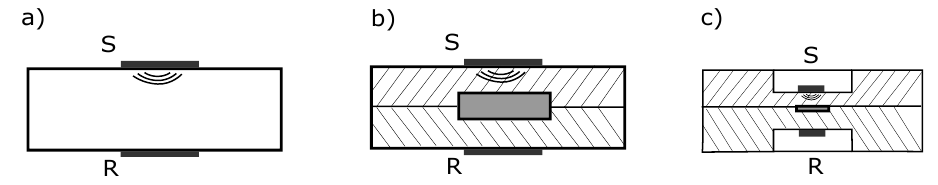
Figure 3. Mould geometries used in this paper. ( a ) A monolithic aluminum piece, ( b ) An aluminum tool with a large cross section of 15 mm × 2 mm, ( c ) A pultrusion tool with a small cross section of 7 mm × 0.5 mm.